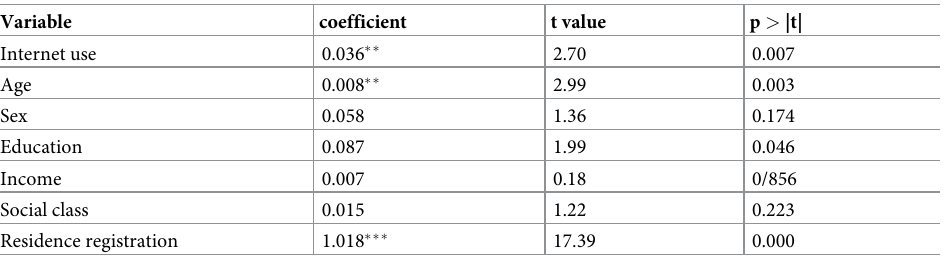
Table 4. Correlation between occupational status and internet use (N = 2,403).